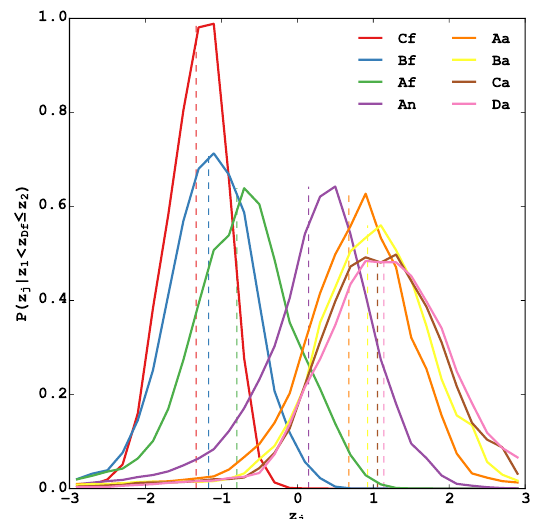
Figure 4. Conditional probability distributions ( P(z j |− 1 <z Df ≤ − 2 ) ) of MISR cameras Cf–Da, for when the z value of the Df cam- era is between − 1 and − 2. The dashed vertical lines show the mean value.